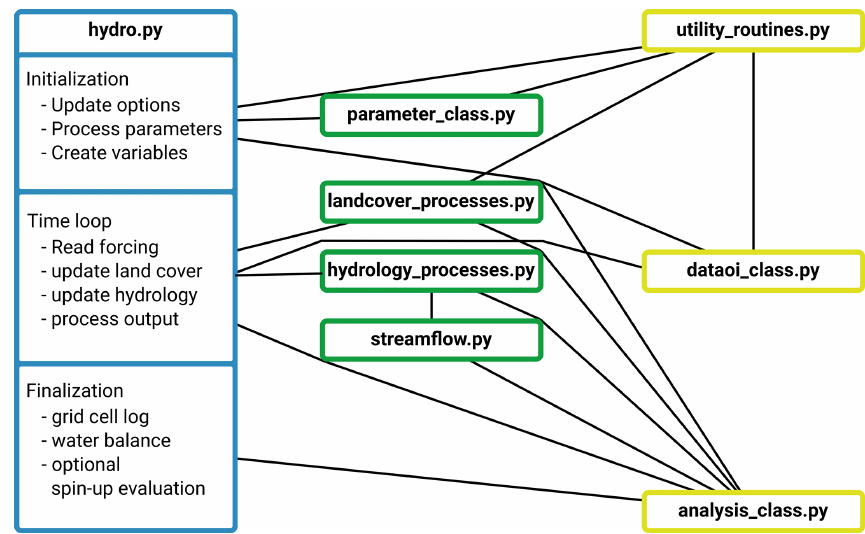
Figure 2. Simplified flowchart of HydroPy depicting the files belonging to the model and their primary interactions. The main routine is shown in blue; process routines are shown in green, and files containing auxiliary functions (I/O, analysis, for example) are shown in yellow.